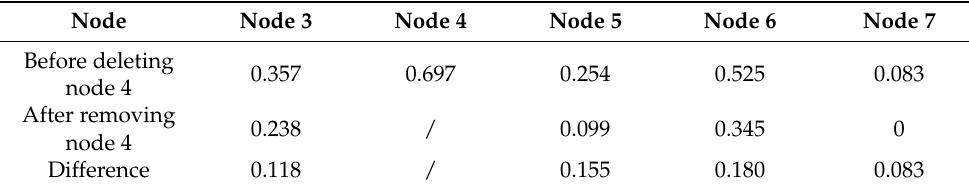
Figure 1. Network topology (Numbers 1–9 represent node numbers in complex networks). Table 1. Changes in importance before and after deleting node